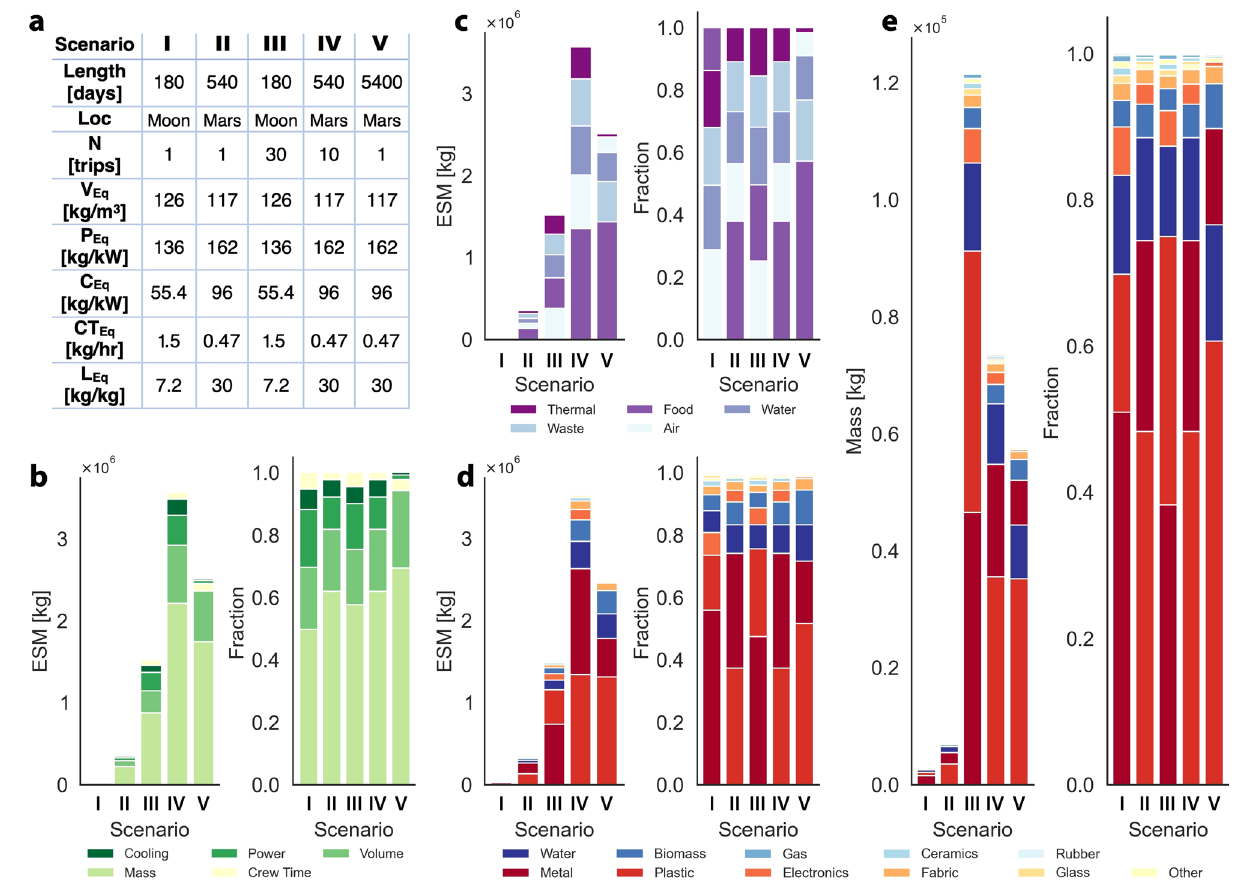
Fig. 2 | Breakdown of environmental control and life support systems into components by type of system and composition thereof. The make-up of the inventory and hence the operational expenses are dependent on the mission- design scenario. Panel ( a ) provides an overview of parameters for fi ve exemplar space-travel scenarios: ‘ I ’ and ‘ II ’ correspond to single sorties ( N ) to the Moon and Mars, respectively, using standard surface operation duration 40 , while ‘ III ’ and ‘ IV ’ correspond to multi-sortie campaigns with the same 5400 days of total surface operation as in ‘ V ’ . Based on these parameters and equivalency factors for Volume ( V eq ),Power ( P eq ),Cooling ( C eq ),Crew-Time ( CT eq ),and Location( L eq ) the ESM can be calculated for each scenario (as per Eq. 1 in section 2 of the SI) 97 . Panels ( b – e )